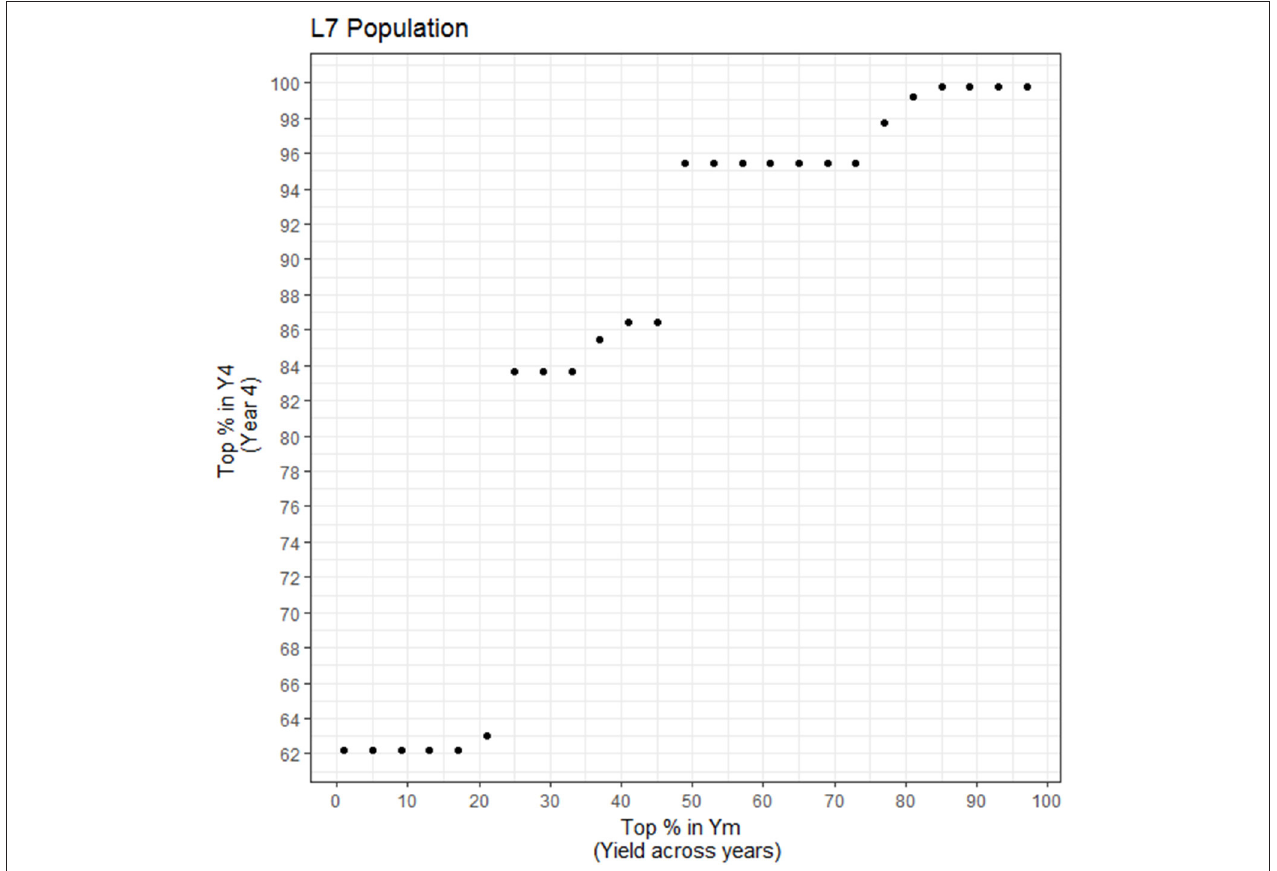
FIGURE 8 | Percentage of the top yielding individuals at year 4 (Y4) needed in order to capture the top percent yielding individuals for average yield (Ym). X-axis: percentage of top individuals taken for Ym; Y-axis. Percentage of Y4 individuals that encompass the selected percentage in Ym (common